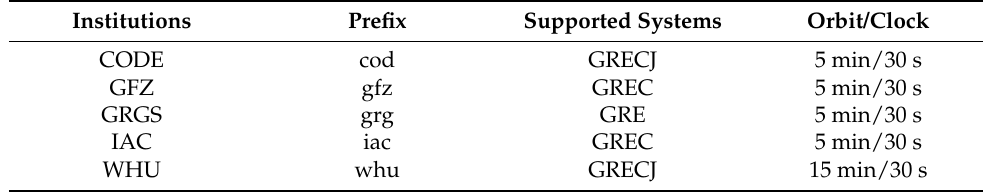
Table 6. Details of the precise products used in this section.